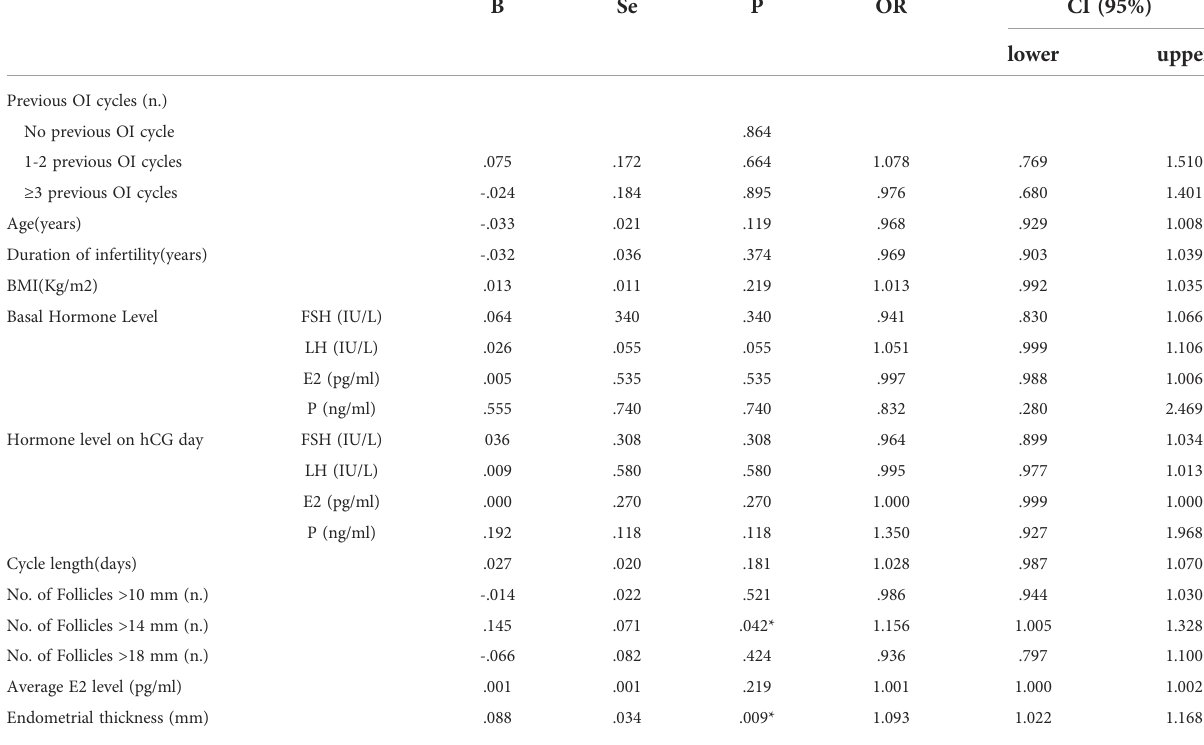
TABLE 4 Logistic regression analysis for pregnancy outcomes of PCOS patients undergoing